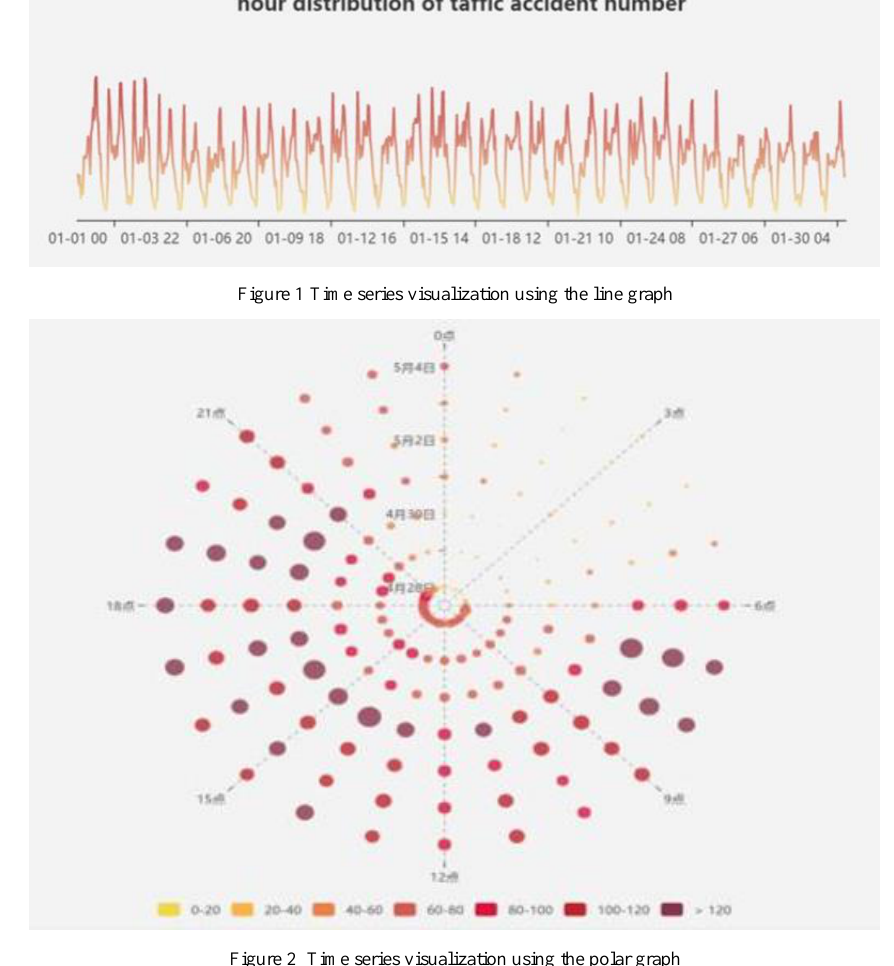
Figure 2 Time series visualization using the polar graph